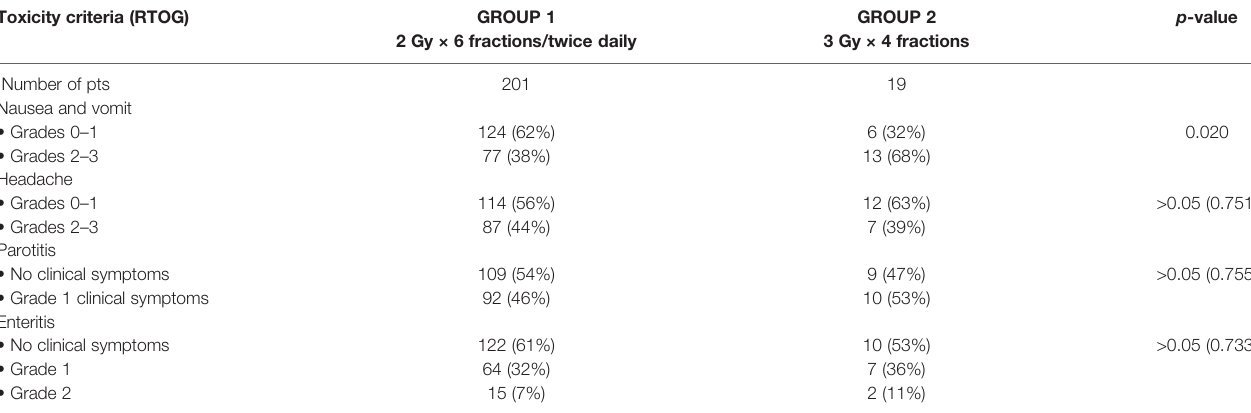
TABLE 4 | Radiation-induced acute